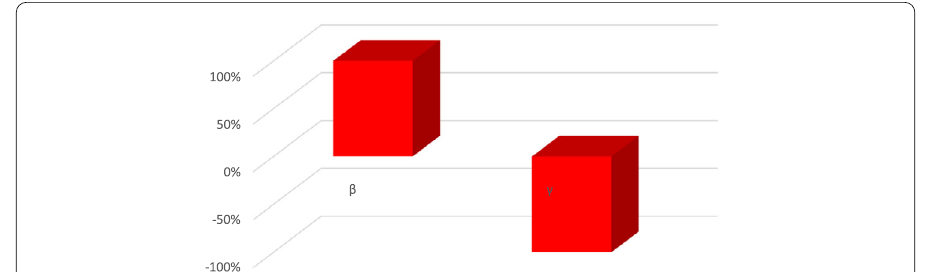
Figure 3 Normalized local sensitivity indices of R 0 via bar chart